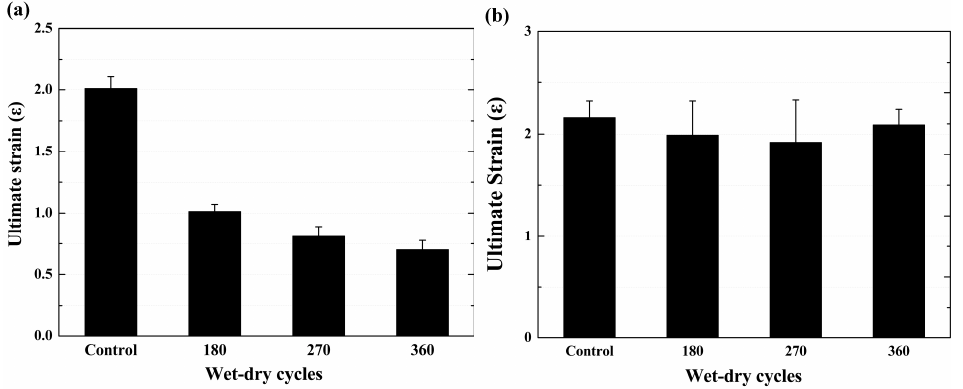
Figure 15. Ultimate strain of the specimens as a function of wet–dry cycles, ( a ) BFRP sheet; ( b ) epoxy resin matrix.